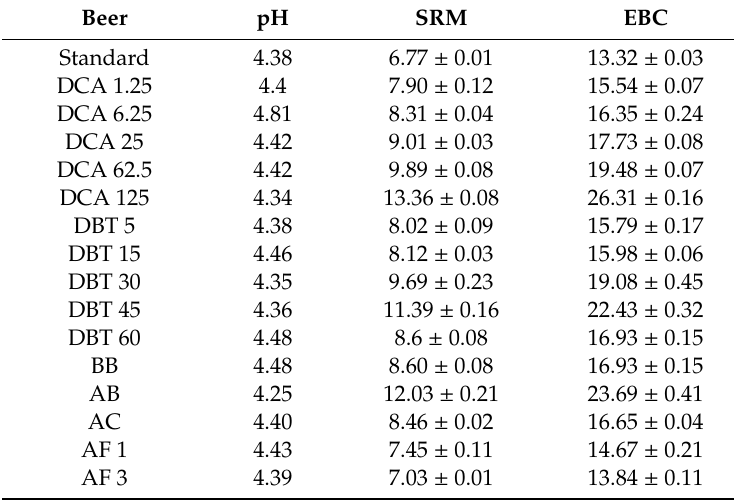
pH, Standard Reference Method (SRM) values and EBC color ratings of Aronia berry-infused